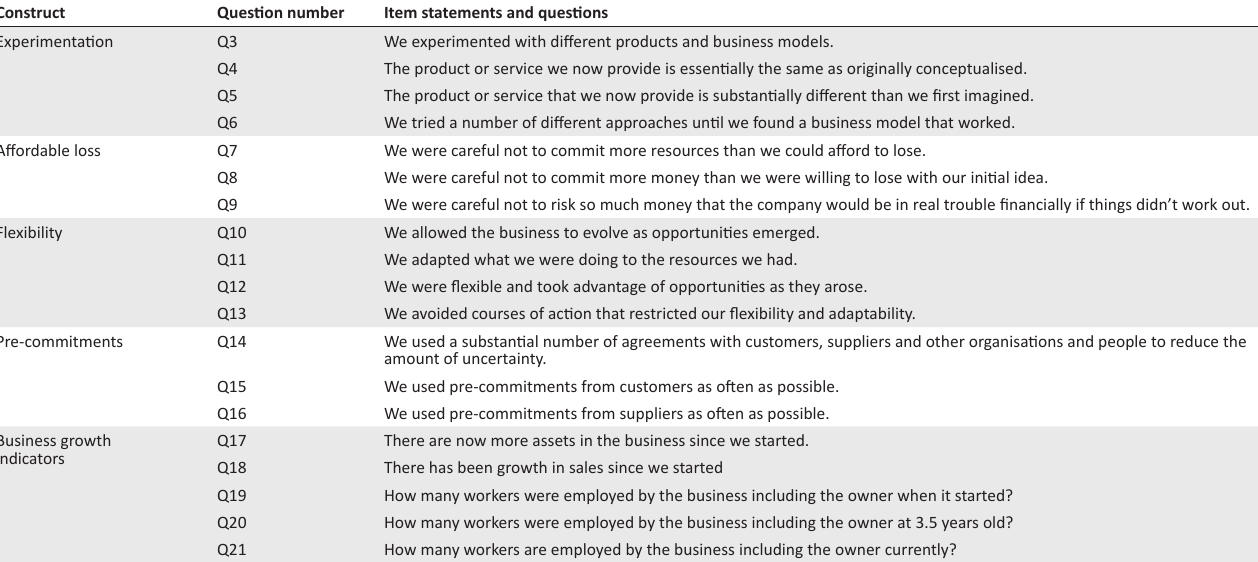
TABLE 2: Statements and questions used with respondents.